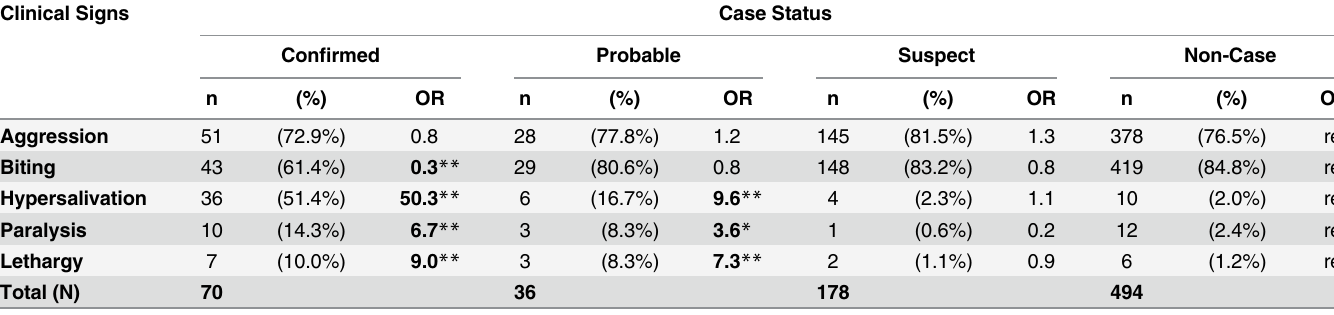
Table 2. Clinical signs observed during investigation of rabies suspect animals by case status, Haiti January 2013 – December 2014. Clinical Signs